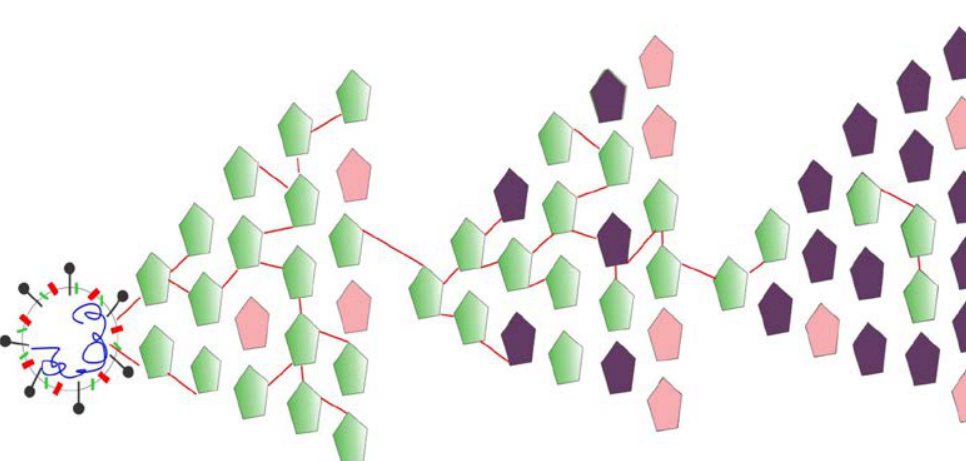
Fig. 5. Journey of the Herd Immunity (The image modified from source